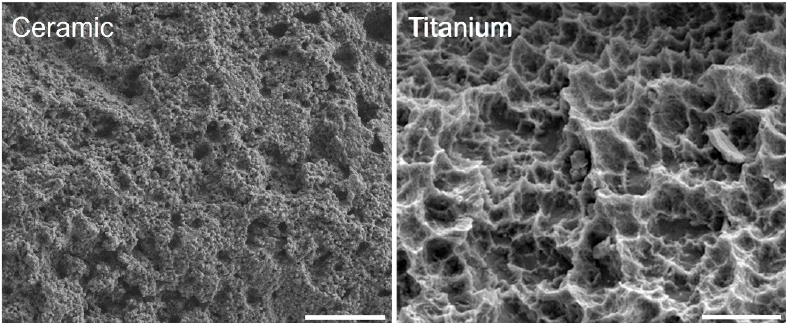
Figure 3. Scanning electron microscopy of dental materials: comparison of ceramic (Material: Vita, zirconia, acid HF; SEM: FE-SEM Merlin, Carl Zeiss, bar 7 µm, 3.000×) versus titanium (Material: Straumann, Ti grade 4, acid HCL and H 2 S0 4 ; SEM: DSM 960A, Carl Zeiss, 10 kV, 3.3 A, bar 7 µm;